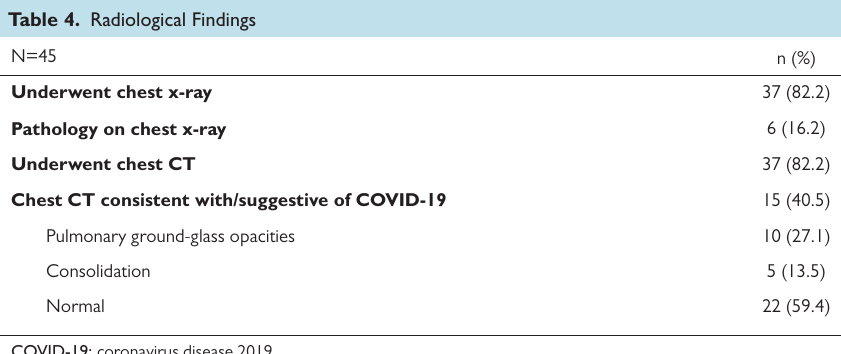
Aspartate aminotransferase: N tested/n > 45 U/L